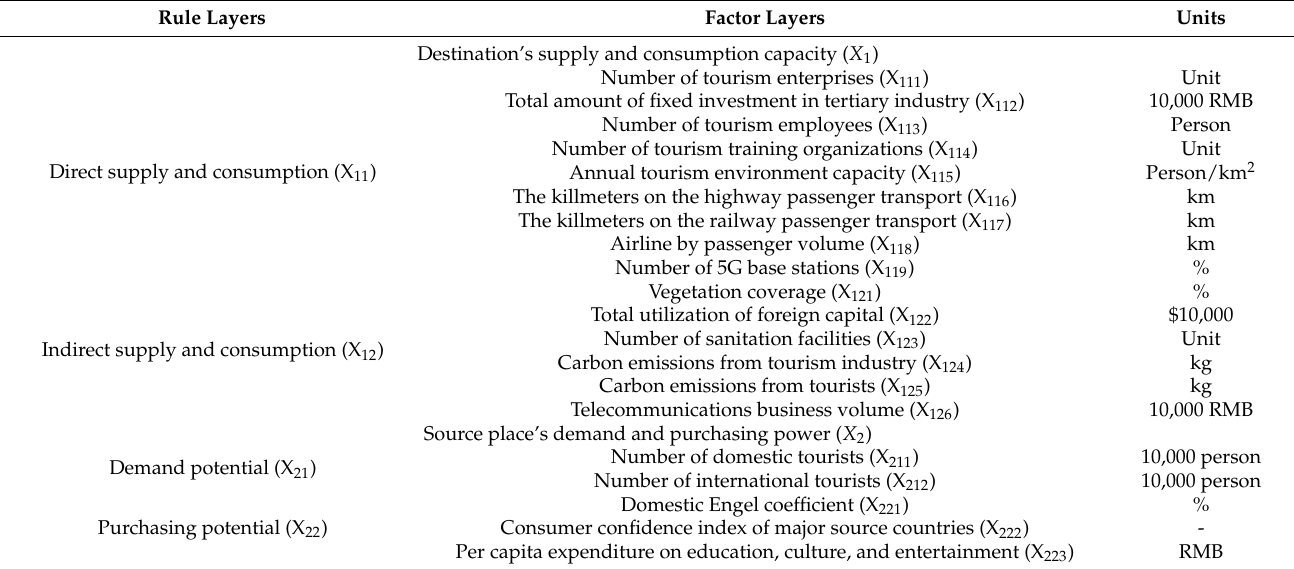
Table 1. The evaluation index system of